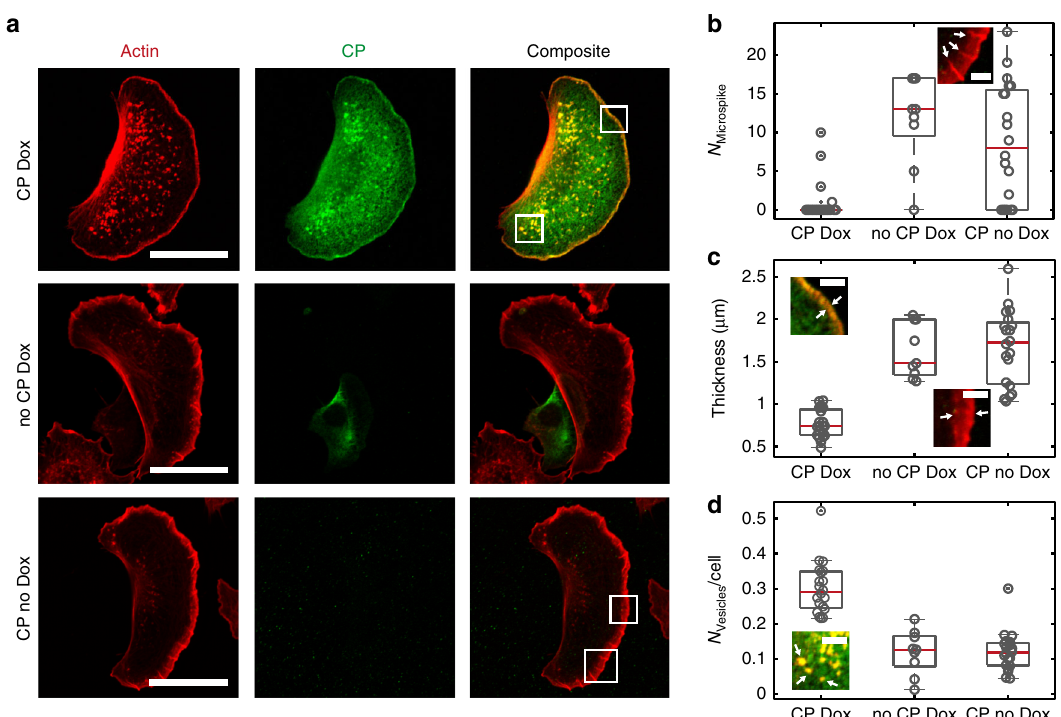
Fig. 6 CP affects membrane deformations in vivo. a The distribution of phalloidin stained F-actin (red) and of CP visualized by HA-Tag antibody labelling (green) in fi xed cells is shown: In the top cells overexpressed CP after induction with 1 µ g/ml Doxycyclin (CP Dox, N = 21). In the middle cells were not overexpressing CP but treated with 1 µ g/ml Doxycyclin (no CP Dox, N = 10) and in bottom cells contained the expression plasmids but were not treated with Doxycyclin (CP no Dox, N = 21). b CP overexpression resulted in the complete loss of microspikes. c CP overexpression decreased lamellipodium thickness. d Formation of actin-containing vesicle was increased in CP overexpressing cells. The number of vesicles was normalized to cell area. Arrows indicated the evaluated objects. The central red line in the boxplots indicates the median. The bottom and top edges of the box mark the 25th and 75th percentiles, respectively. The whiskers got to the most extreme considered data point. Not considered data points are marked by a dot in the centre of the data point. Scale bars in a are 20 µ m and in b – d are 3 µ